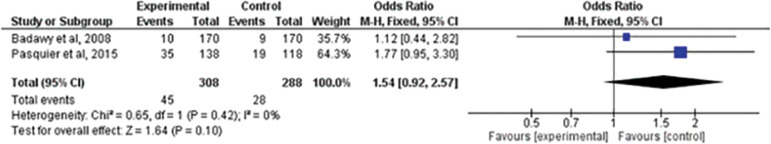
Forest-plot of hemorrhage incidence with treatment